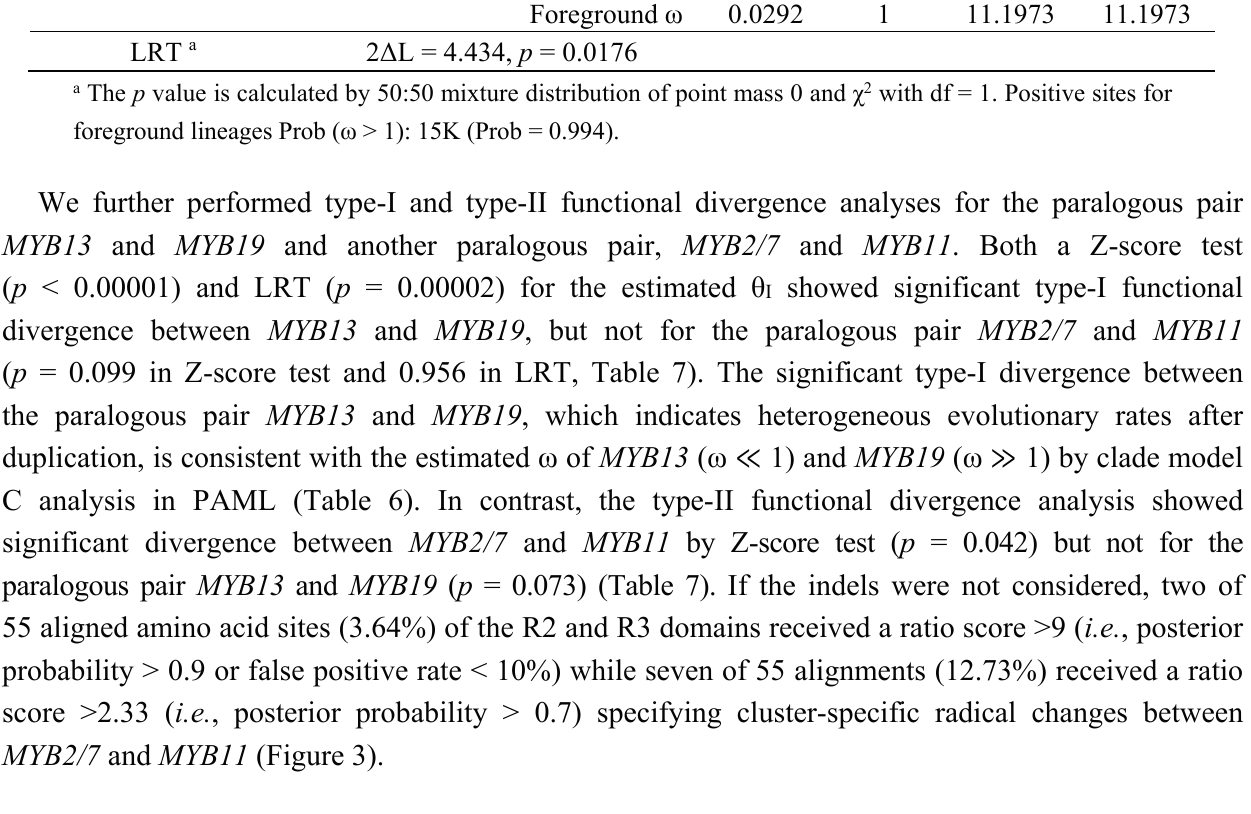
Table 7. Summary of type-I and type-II functional